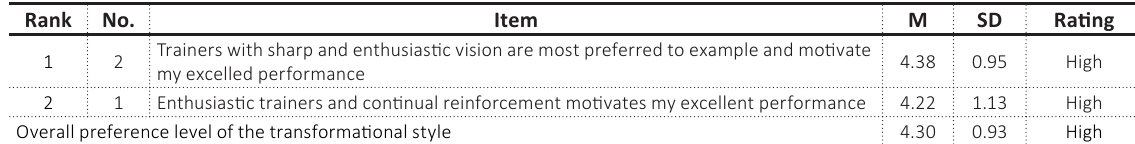
Table 9. Means and standard deviations of respondent responses to items measuring the transformational style in descending of